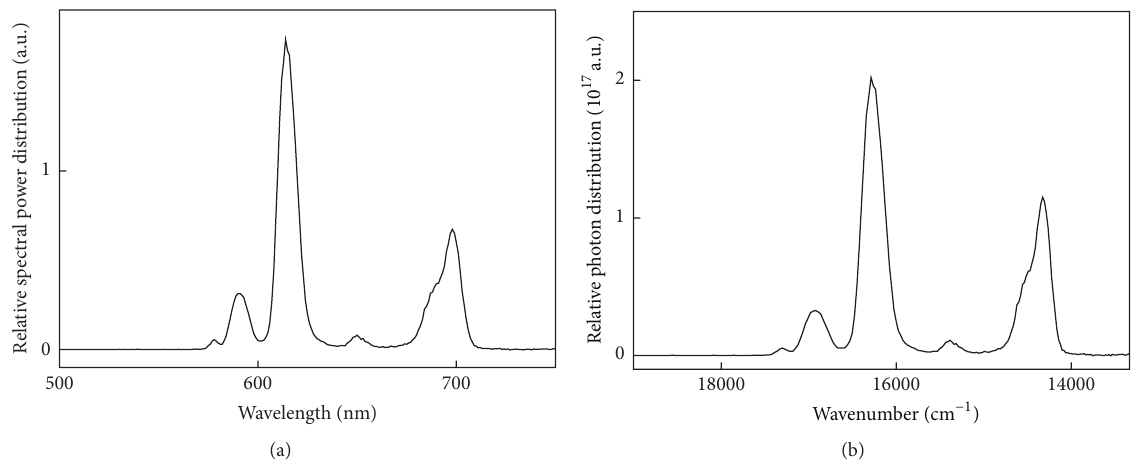
Figure 6: (a) Relative spectral power distribution and (b) relative photon distribution of 0.2 wt% EBA incorporated PMMA under 254 nm